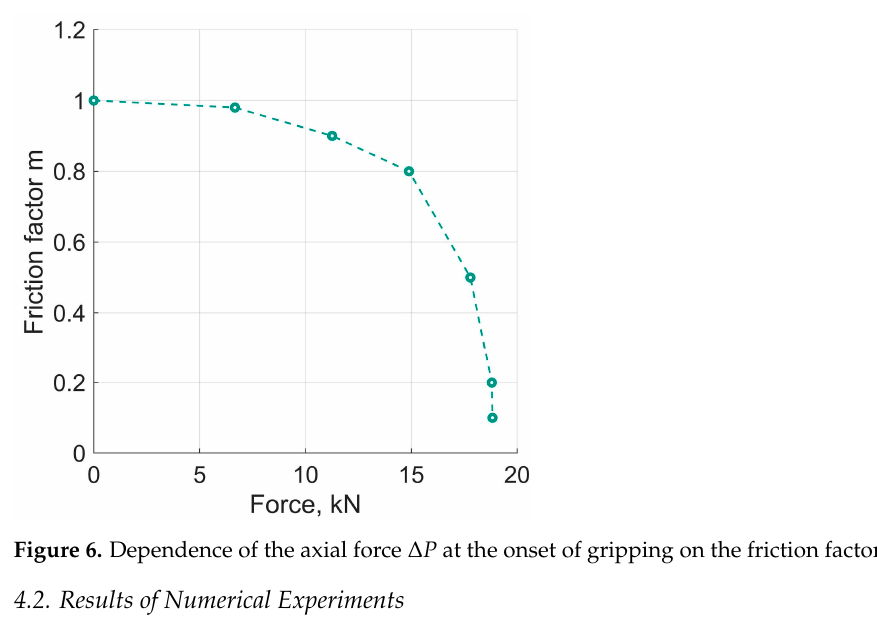
Figure 6. Dependence of the axial force ∆ P at the onset of gripping on the friction factor m.